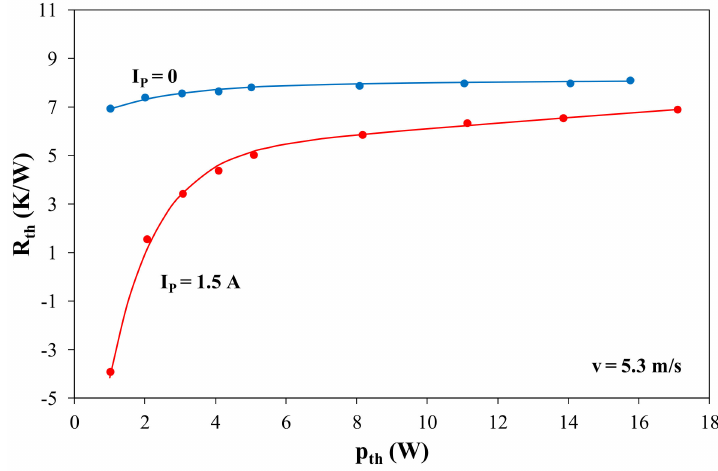
Figure 15. Measured and modelled dependences of the thermal resistance of the resistor operating in system E on the dissipated power at selected values of the current feeding the Peltier module (system